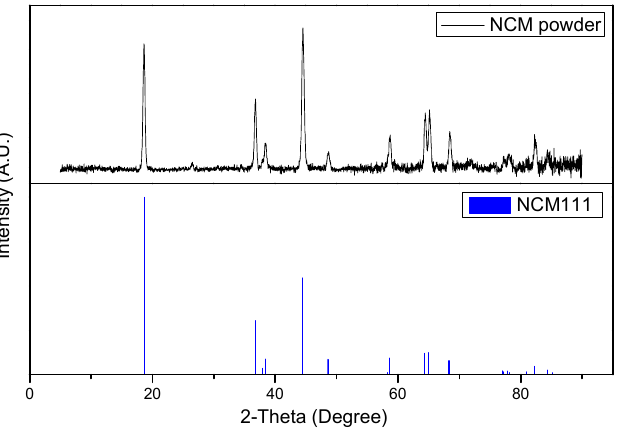
Figure 1. The results of the XRD analysis and the major peaks of NCM powder.